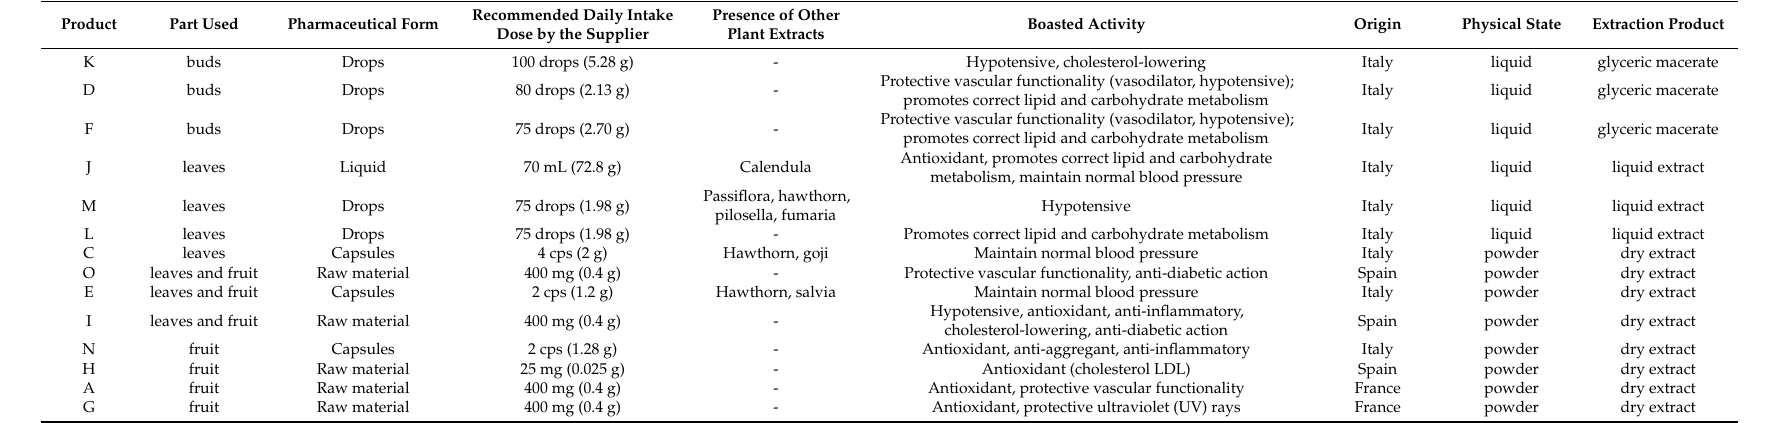
Table 4. Summary of the characteristics of the supplements included in the present